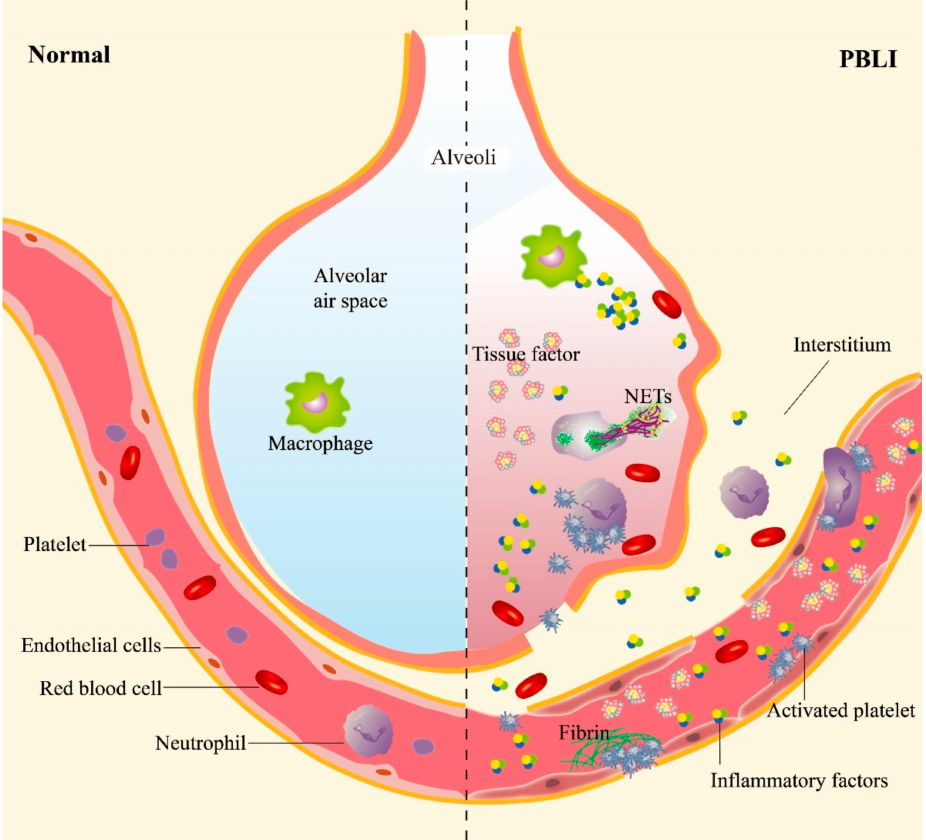
Figure 1. The main pathological manifestations in PBLI. The main pathological manifestations of PBLI are pulmonary hemorrhage, inflammation, and coagulation disorders. The shockwave caused rupture of the pulmonary capillaries, destruction of the alveoli, and entry of red blood cells into the alveolar space and interstitium. Inflammation is manifested by leukocyte infiltration and increased levels of proinflammatory cytokines in the lung. Coagulation disorders are characterized by the aggregation of activated platelets to form platelet thrombi and the gradual formation of fibrin thrombi. NETs: neutrophil extracellular